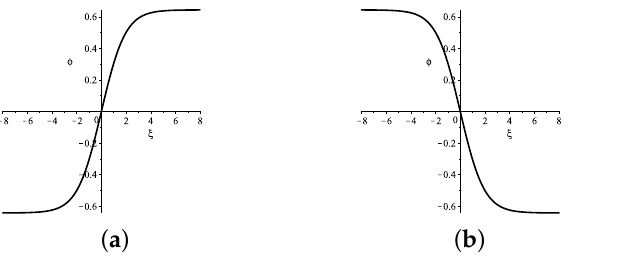
Figure 15. Kinkand anti-kink wave forms of system (5). ( a ) Kink wave given by (35). ( b ) Anti-kink wave given by (36).